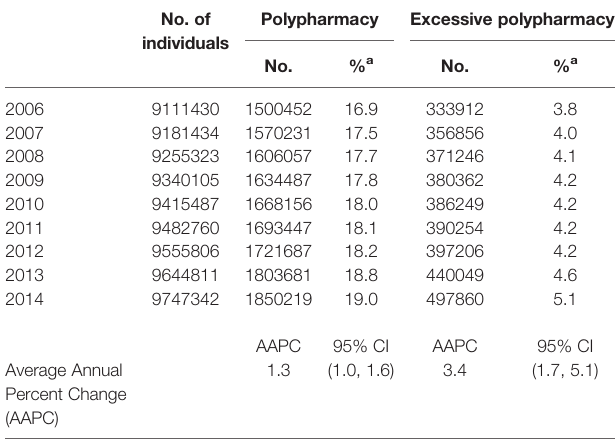
TABLE 2 | Age-standardized rate of polypharmacy and excessive polypharmacy between 2006 and 2014. No. of Polypharmacy Excessive polypharmacy individuals No.